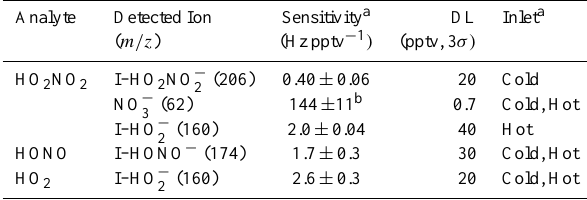
Table 1. Summary of observed products, sensitivities, and detection limits (DL) for the reaction of I − with HO 2 NO 2 , HONO, and HO 2